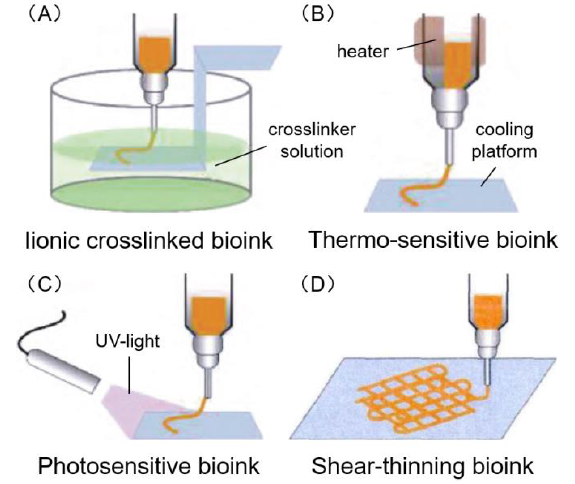
Figure 4. Four common types of bioink. ( A ) Ionic crosslinking bioink mainly performs the solidification through ionic crosslinking reaction. ( B ) Thermo-sensitive bioink mainly performs the transformation from sol to gel state by heating or cooling. ( C ) Photosensitive bioink mainly performs the transformation from sol to gel state by activating the light initiator in bioink. ( D ) Shear-thinning bioink mainly performs the solidification through shear force. The viscosity of some materials decreases with the increase of shear stress, while gelation on the platform occurs with no shear stress. Adapted with permission from [66]; copyright Journal of Zhejiang University (Engineering Science), 2019.